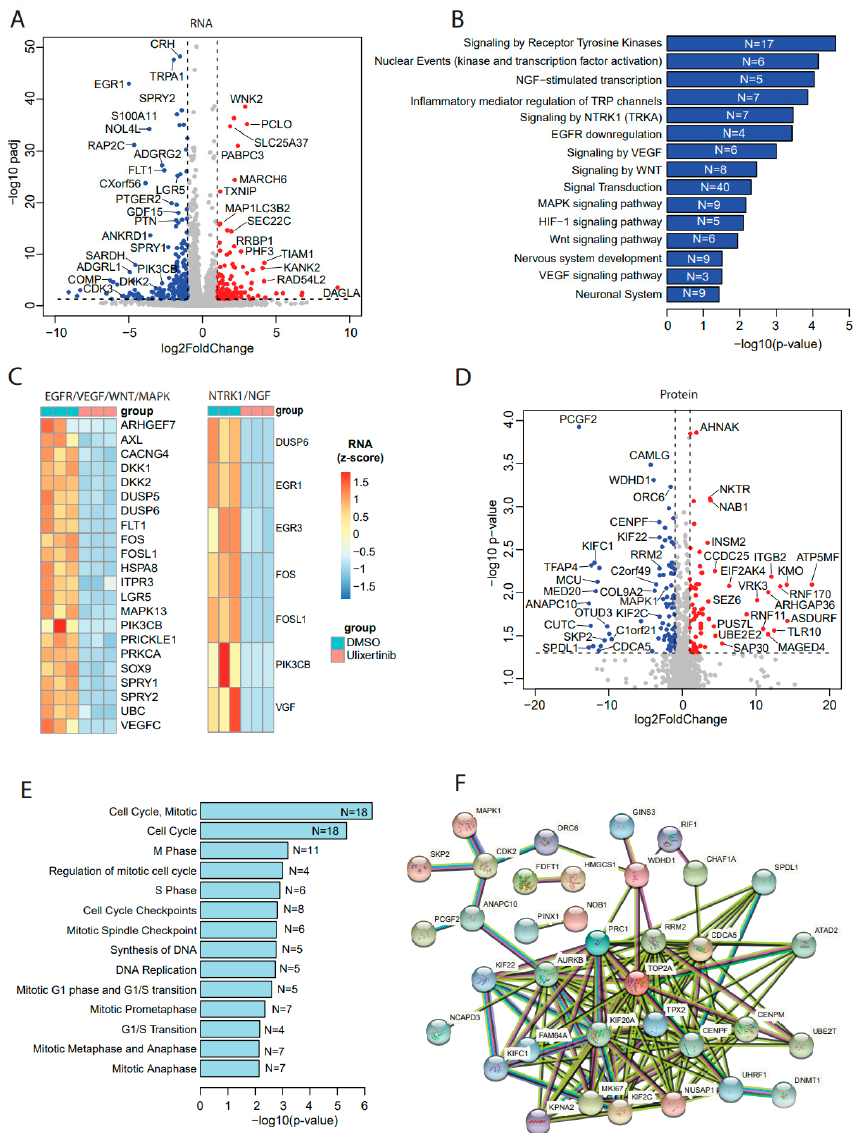
Figure 3. Transcriptomics and proteomics reveal ulixertinib-induced gene changes in NGP cells. ( A ) The differentially expressed genes revealed by DESeq2 analysis of RNA-Seq read counts. They are represented in the volcano plot in terms of their measured expression change (log2 of fold changes, x -axis) and the significance of the change ( − log10 of adjusted p values, y -axis). The dotted lines represent the thresholds to define the differentially expressed genes. Red dots are up-regulated genes after the drug treatment (fold changes ≥ 2 and adjusted p < 0.05). Blue dots are down-regulated genes with the drug treatment (fold changes ≤ 0.5 and adjusted p < 0.05). ( B ) Top inhibited pathways revealed by down-regulated genes from RNA-Seq. N is number. ( C ) Key components inhibited and their associated pathways. ( D ) The differentially expressed proteins from MS were represented in the volcano plot in terms of their measured expression change (log2 of fold changes, x -axis) and the significance of the change (-log10 of p values, y -axis; unpaired t -test). The dotted lines represent the thresholds to define the differentially expressed proteins. Red dots are up-regulated proteins after the drug treatment (fold changes ≥ 2 and p < 0.05). Blue dots are down-regulated proteins with the drug treatment (fold changes ≤ 0.5 and p < 0.05). ( E ) Top inhibited pathways revealed by downregulated proteins from MS. N is number. ( F ) Protein–protein interaction networks analysis of down-regulated proteins from MS.